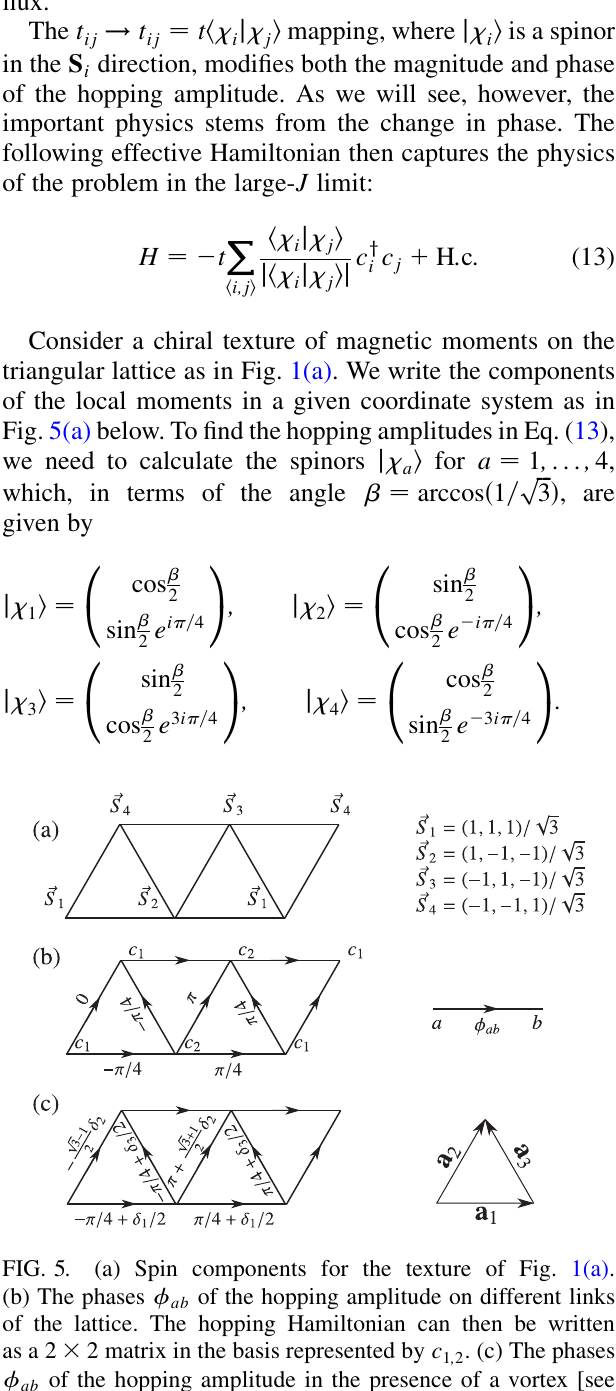
. (c) The phases 1 ; 2